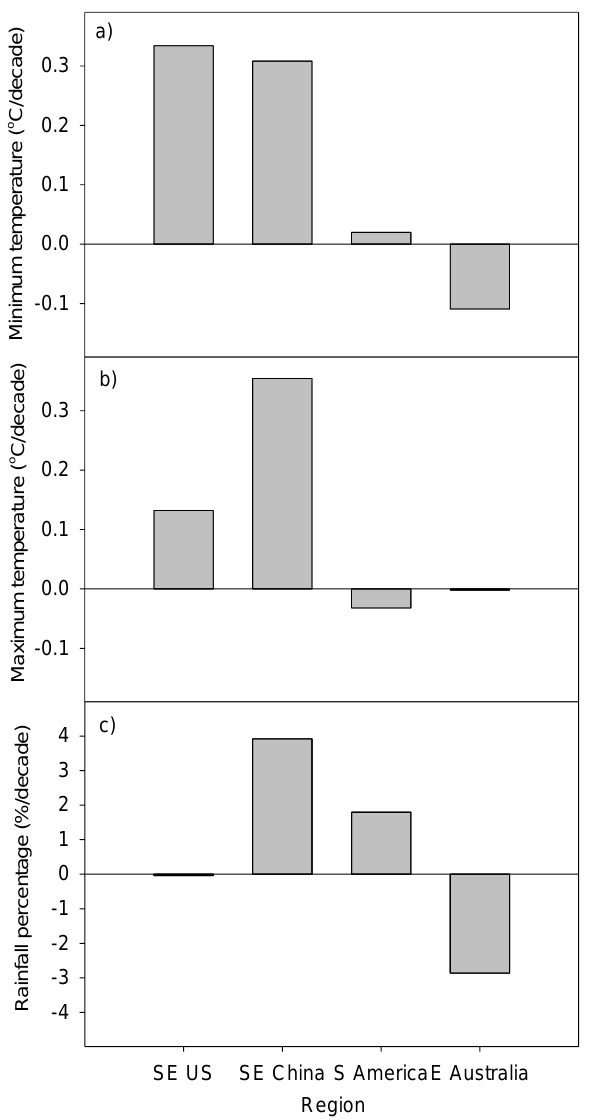
Figure 5. Past decadal trend in ( a ) minimum temperature, ( b ) maximum temperature, and ( c ) annual mean rainfall for humid subtropical regions in the southeast U.S. (SE U.S.), southeast China (SE China), South America (S America), and east Australia (E Australia) from 1981 to 2010. [39] . Rainfall trends are more variable in the humid subtropics, with Southeast China showing a 3.9% increase per decade. In the Southern Hemisphere, east Australia shows a decline of −2.9% of annual